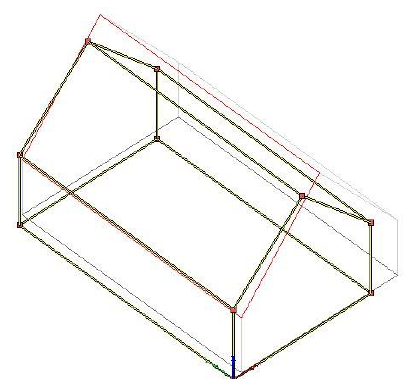
Figure 6. Uncertain geometry instance deviating from highlighted reconstructed